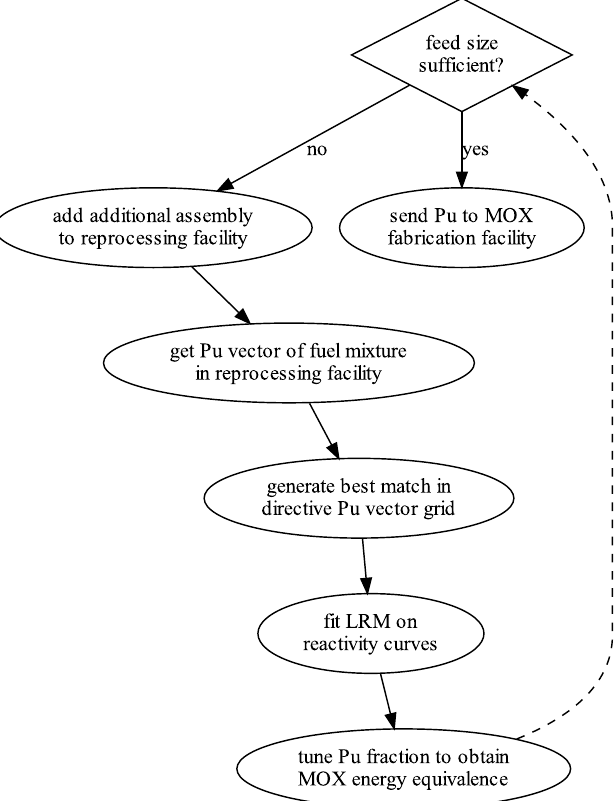
Fig. 5. Process flow diagram of the MOX equivalence Python code